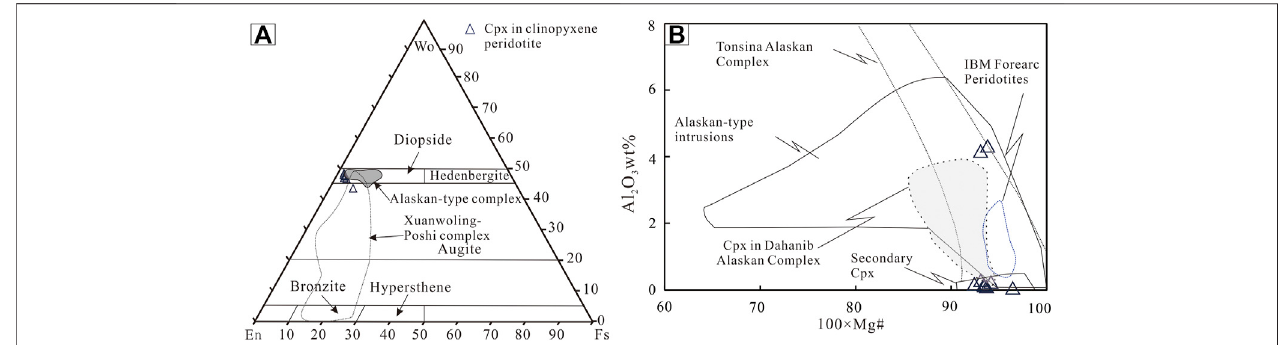
FIGURE 11 | (A) The clinopyroxenes are classi fi ed as diopside and plot in the Alaskan-type complex fi eld, the classi fi cation triangle diagrams of pyroxenes after Morimoto et al. (Morimoto., 1989). (B) Al 2 O 3 (wt%) versus Mg# diagrams of Cpxs are similar to Alaskan-type intrusions. The fi elds of Alaskan-type intrusions, Tonsina